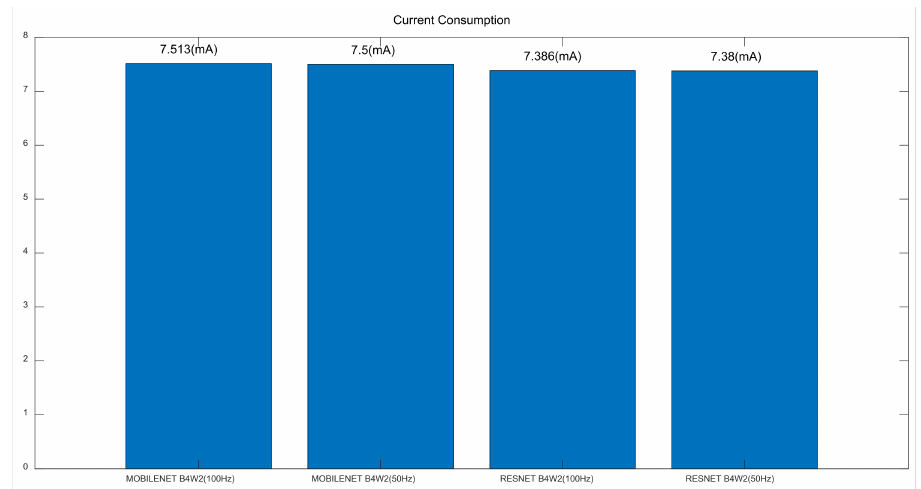
Figure 7. Current